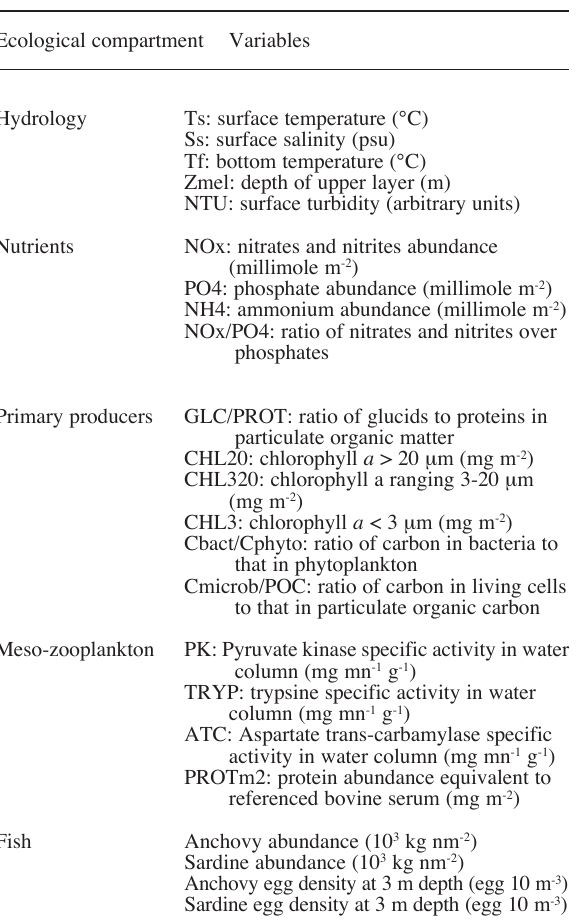
pelagic survey performed in may 2000 (PEL2000) with R/V “Thalassa”.